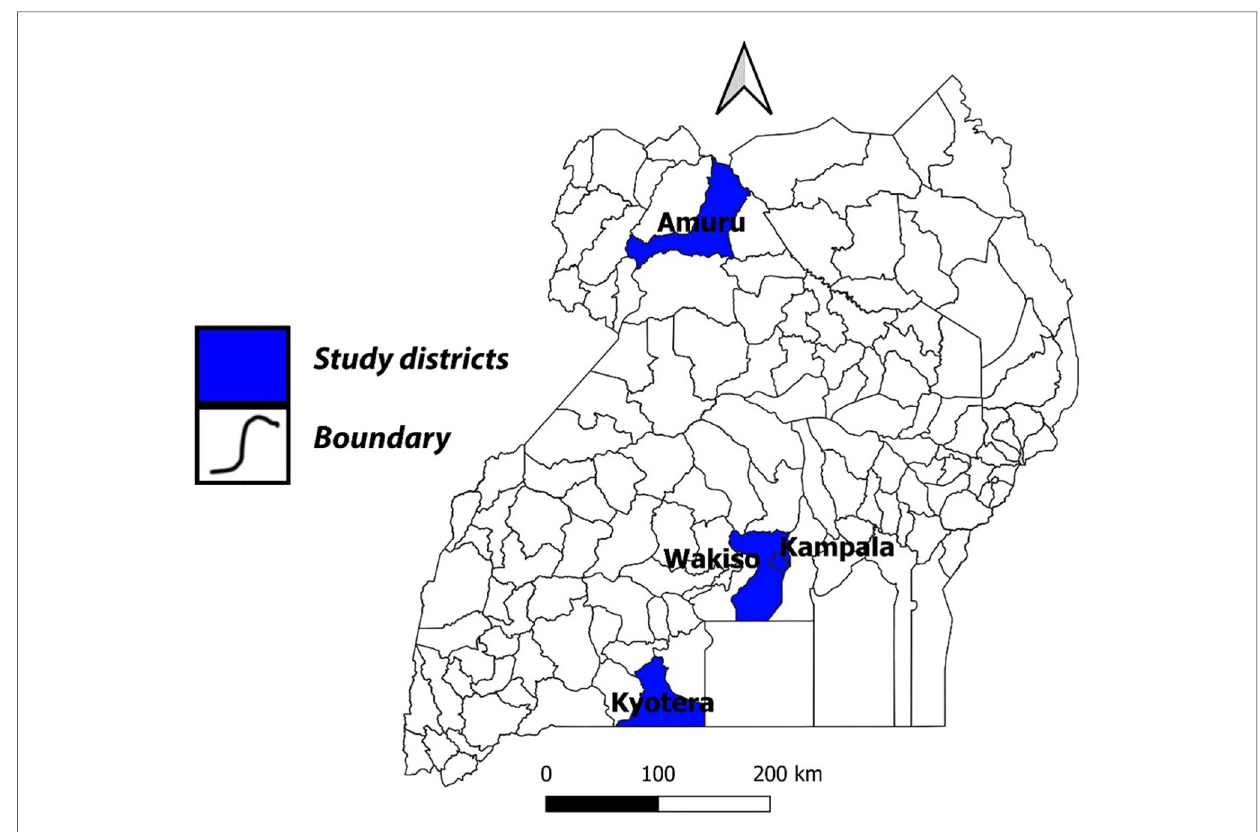
FIGURE 1 Map of Uganda showing the Amuru, Kyotera, Wakiso, and Kampala